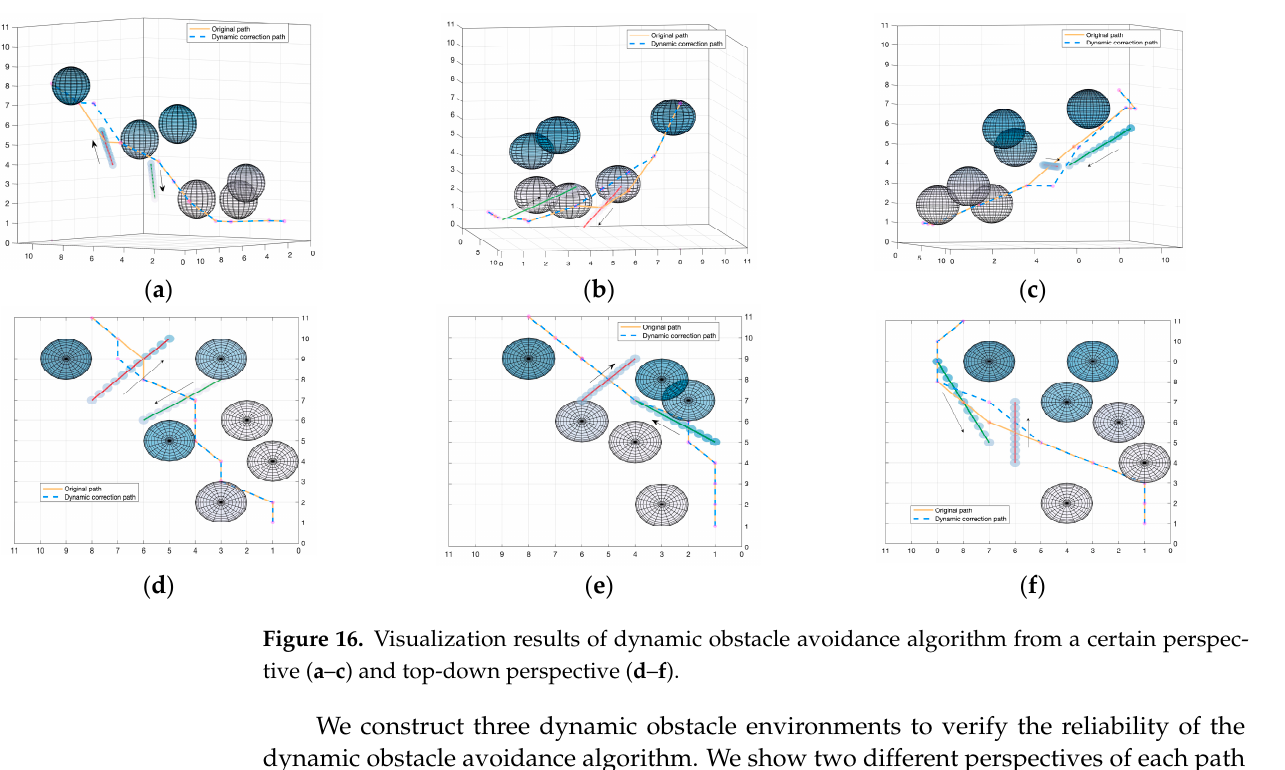
Figure 16. Visualization results of dynamic obstacle avoidance algorithm from a certain perspective ( a – c ) and top-down perspective ( d – f ).